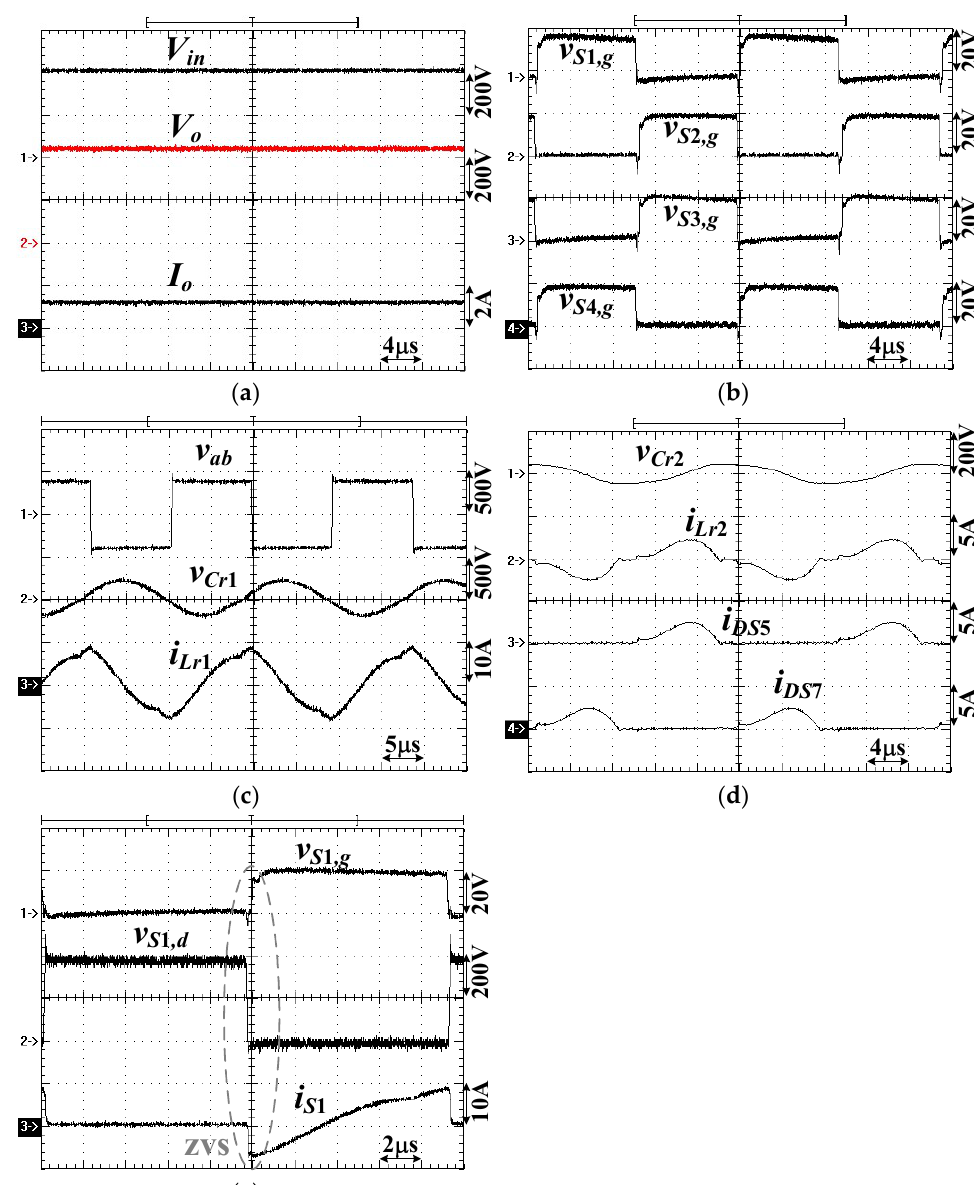
Figure 13. Experimental waveform of the proposed converter at V o = 450 V and the rated load current